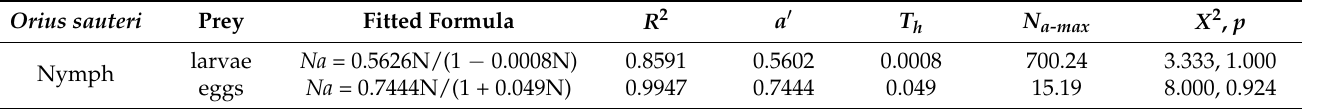
Table 1. Parameters of the functional response of Orius sauteri preying on Spodoptera frugiperda .